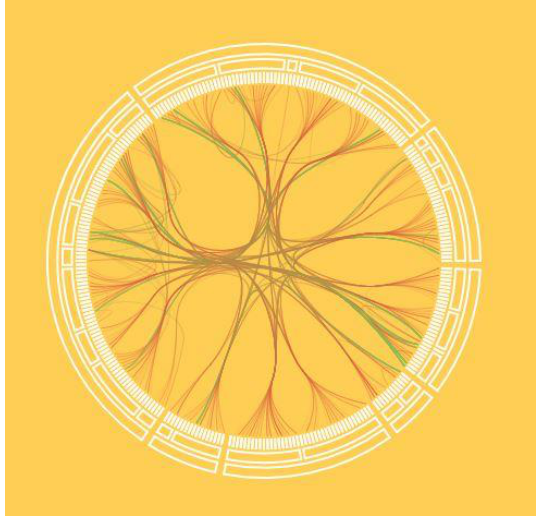
Figure 12. Chord diagram with seventh-order Bezier curves. Bezier curves allow one to “wisp” the connections of an unconnected graph and improve the readability of the image.